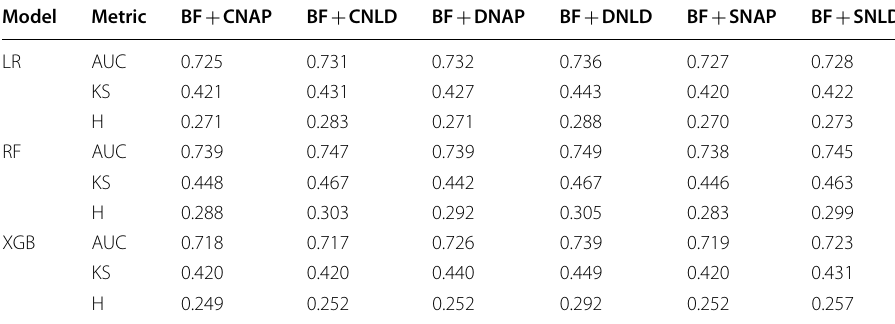
Table 31 Discrimination performance of different feature sets